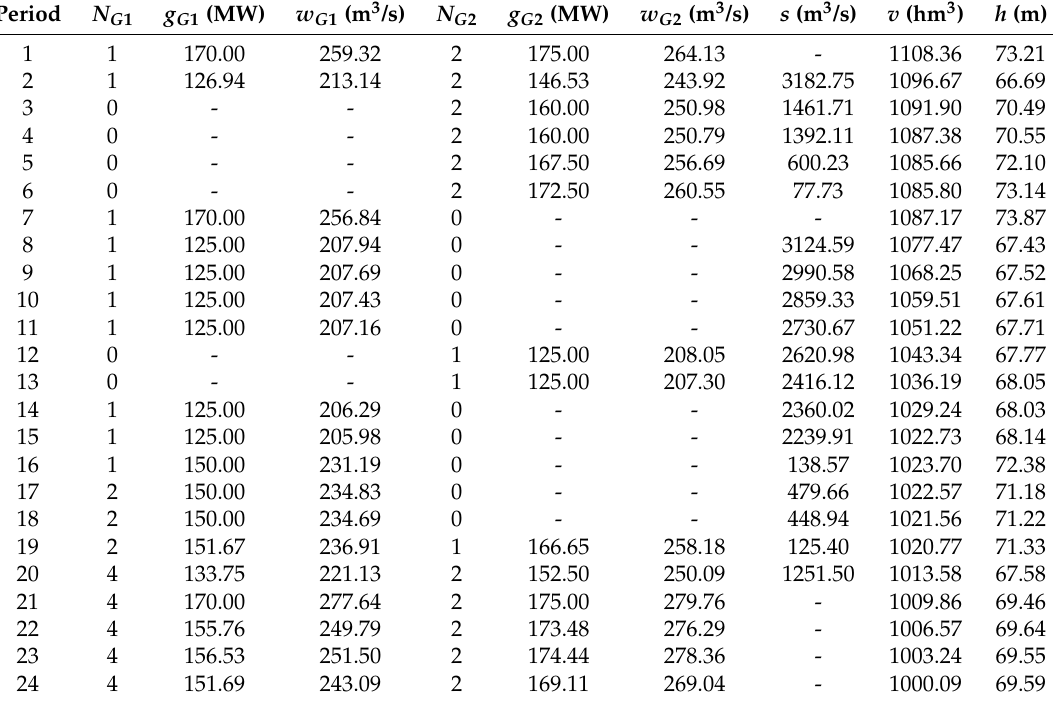
Table 7. Results with power losses-based objective function-scenario 2.